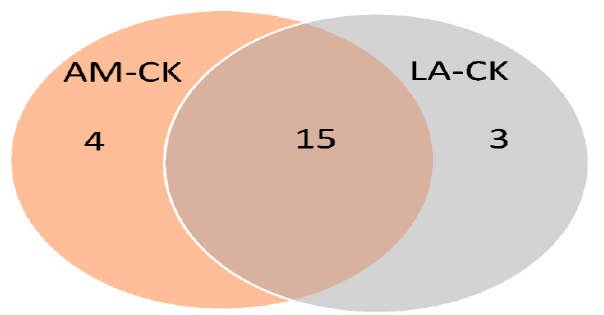
Figure 4. Distribution of biological processes (GO level 3) associated with differentially expressed proteins after treatment with AM and LA. LA: lactic acid; AM: acid mixture, 0.8% LA + 0.2% AA; CK: control.